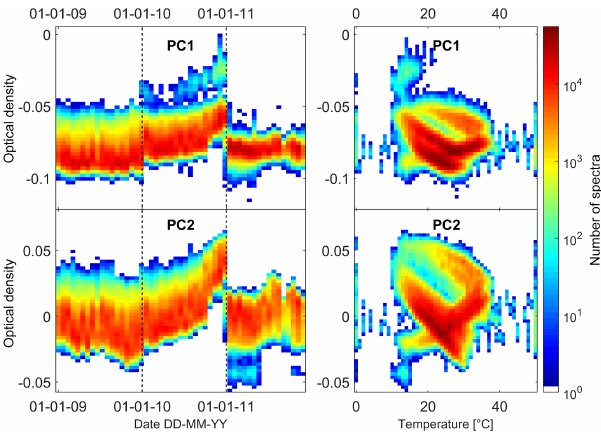
Figure 4. Peak-to-peak apparent optical density of the first and sec- ond principal components, as Fig. 3, but for instrument I2J8548 at Tungurahua. The vertical dashed lines indicate the start of the inter- vals for which a new set of principal components was calculated. In contrast to the case shown in Fig. 3 here both PC1 and PC2 show a temporal drift but a rather chaotic temperature dependence. It is in- teresting to note that the instruments at Tungurahua show behaviour similar to this figure, while both spectrometers at Nevado del Ruiz both show a behaviour similar to the one shown in Fig. 3